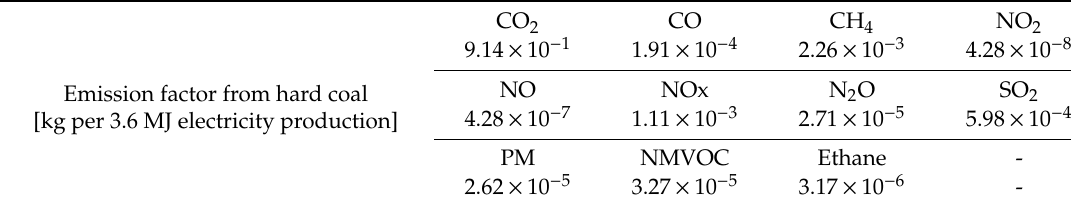
Table A5. Emission factors of energy source from hard coal at the Well-to-Tank